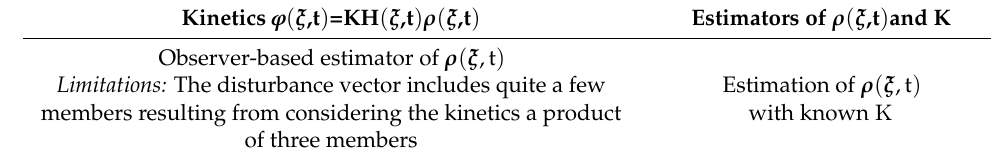
Table 5. Parameter estimators.